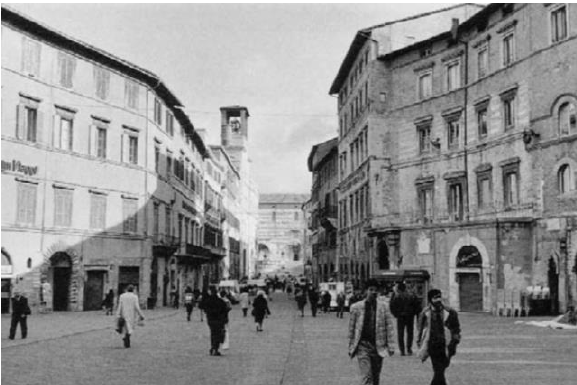
Figure 9. Corso Vannucci, Perugia.